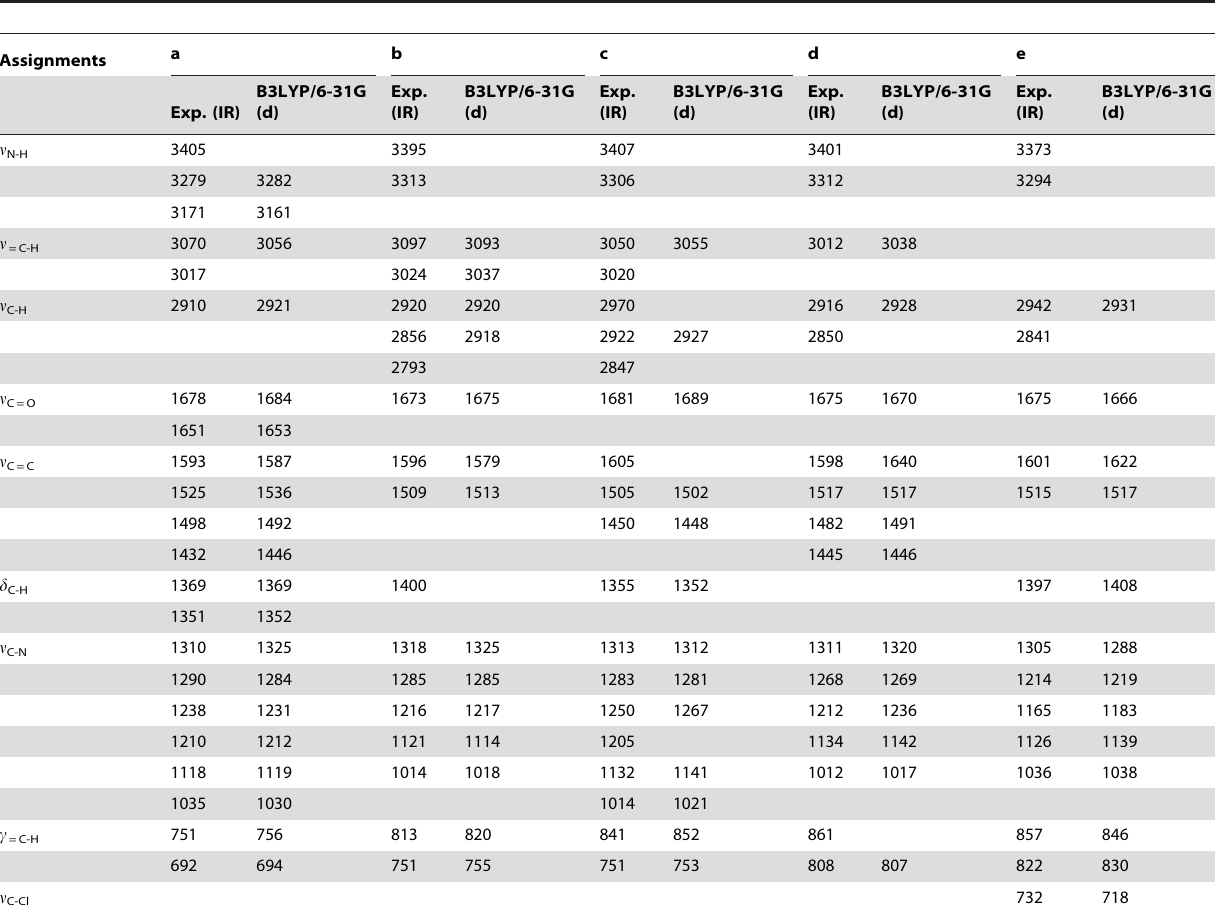
Table 4. Experimental and calculated vibrational frequencies (cm 2 1 ) with DFT method.